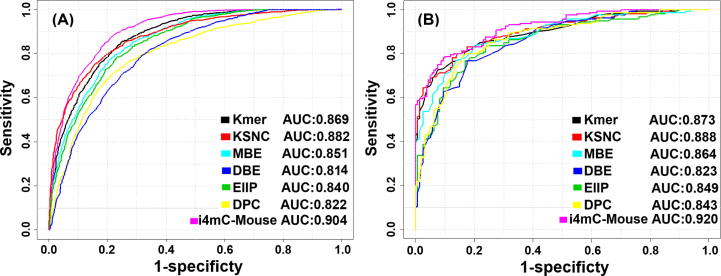
Performance comparisons of single encoding-based models and i4mC-Mouse. The ROC curves were evaluated on the training dataset by a 10-fold CV test (A) and independent dataset (B).